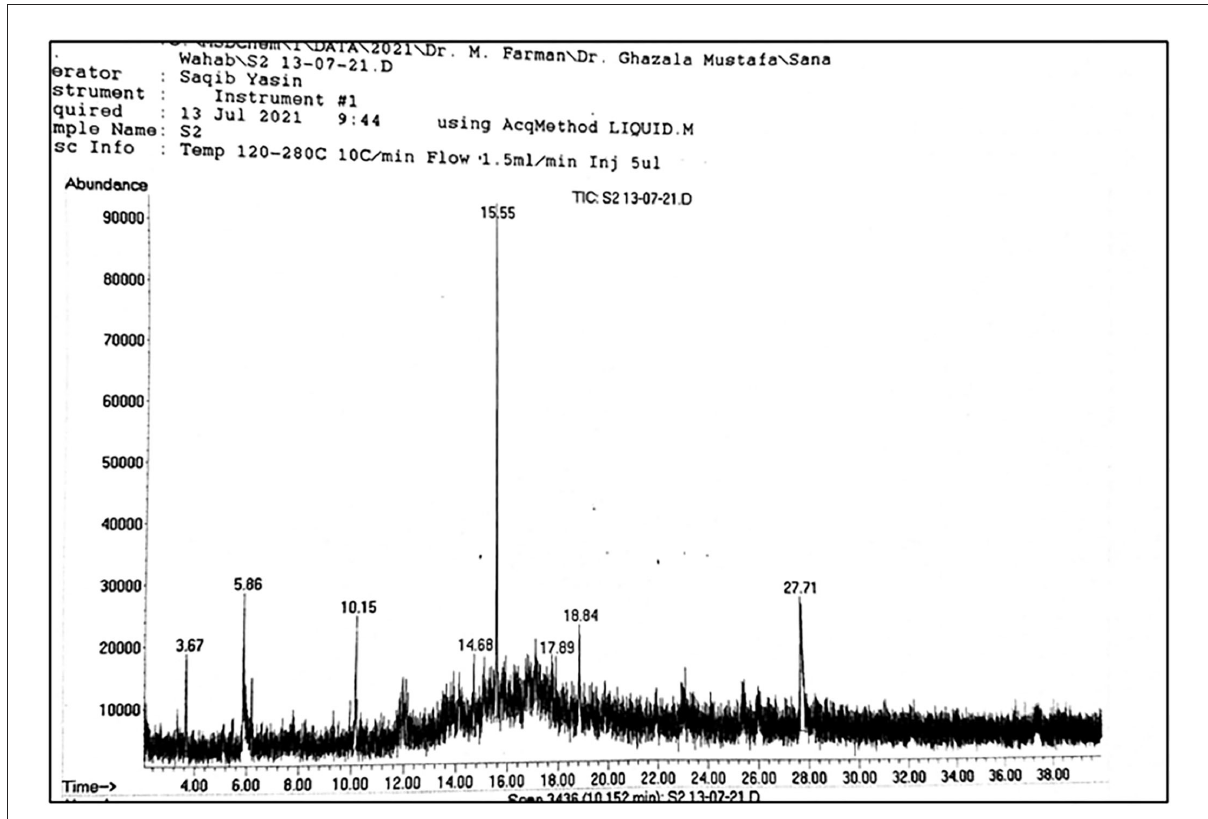
FIGURE3 GC-MS spectrum of different compound extracted from seed